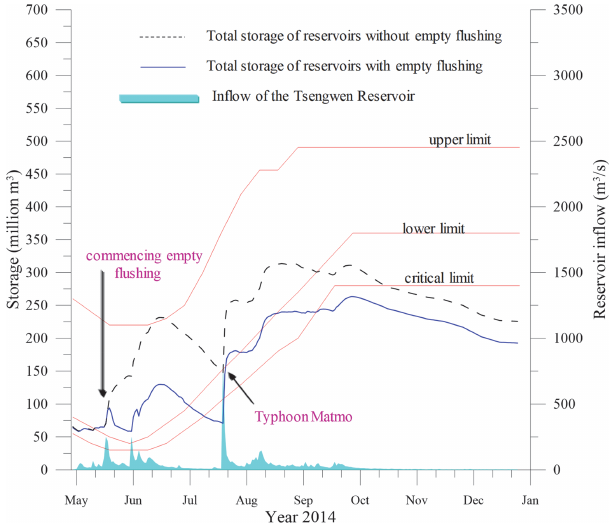
Figure 12. Reservoir inflow and storage throughout